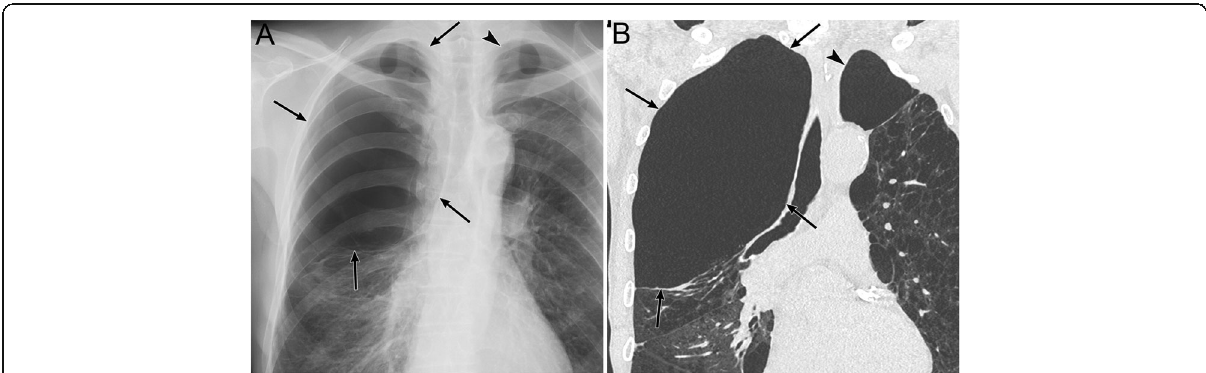
Fig. 10 A giant bulla mimicking pneumothorax on a radiograph in a 67-year-old man. He has chronic obstructive pulmonary disease and a cigarette smoking habit. a A giant bulla appears as an oval radiolucency (black arrows) in the right lung apex on an erect radiograph. It resembles pneumothorax in the apicolateral space. Bullous emphysema exists in both lungs, and a large bulla is observed in the left lung apex (arrowhead). b A coronal CT image reveals a giant bulla (black arrows) in the right lung apex. A large bulla (black arrowhead) also exists in the left lung apex in addition to bullous changes in both